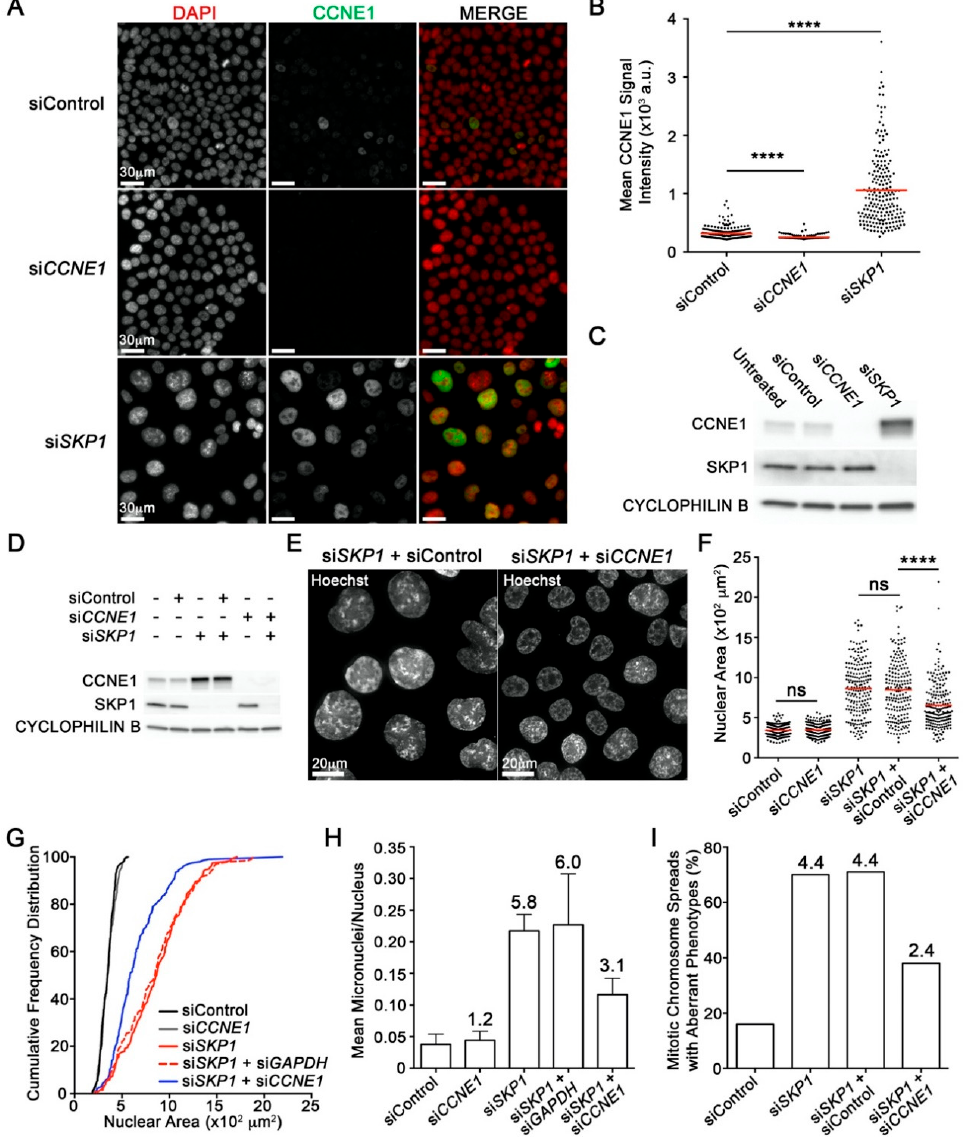
Figure 5. SKP1 Silencing Induces Increases in Cyclin E1 (CCNE1) Levels that Contribute to CIN. ( A ) Qualitative micrographs showing visual increases in CCNE1 (green) levels following SKP1 silencing in HCT116 cells. Images were acquired using identical exposure times. ( B ) Dot plot showing statistically significant increases in mean CCNE1 signal intensity (red line) in si SKP1 cells relative to siControl (Student’s t-test, **** = p -value < 0.0001). ( C ) Western blot confirms CCNE1 protein levels increase following SKP1 silencing. See Figure S4A for detailed information. ( D ) Western blot showing effective individual and co-silencing of SKP1 and CCNE1 in HCT116 cells. See Figure S4B for detailed information. ( E ) Qualitative images showing visual decreases in NAs (phenotypic rescue) in co-silenced (si SKP1 + si CCNE1 ) cells relative to control (si SKP1 + siControl) cells. ( F ) ScQuantIM reveals significant decreases in mean NAs (red line) following co-silencing (si SKP1 + si CCNE1 ) relative to control (si SKP1 + siControl) (Student’s t -test, p -value <0.0001). ( G ) Co-silencing (si SKP1 + si CCNE1 ) induces a significant phenotypic rescue (leftward shift) towards a smaller NA distribution relative to si SKP1 or si SKP1 + siControl (KS test, p -value <0.0001). ( H ) Bar graph showing a decrease in mean MN formation (+ SD) following co-silencing (si SKP1 + si CCNE1 ) relative to controls (si SKP1 or si SKP1 + siControl); fold increase relative to siControl is presented above each bar. ( I ) Bar graph showing a decrease in the percentage of aberrant mitotic chromosome spreads following co-silencing relative to si SKP1 or si SKP1 + siControl; fold increase is